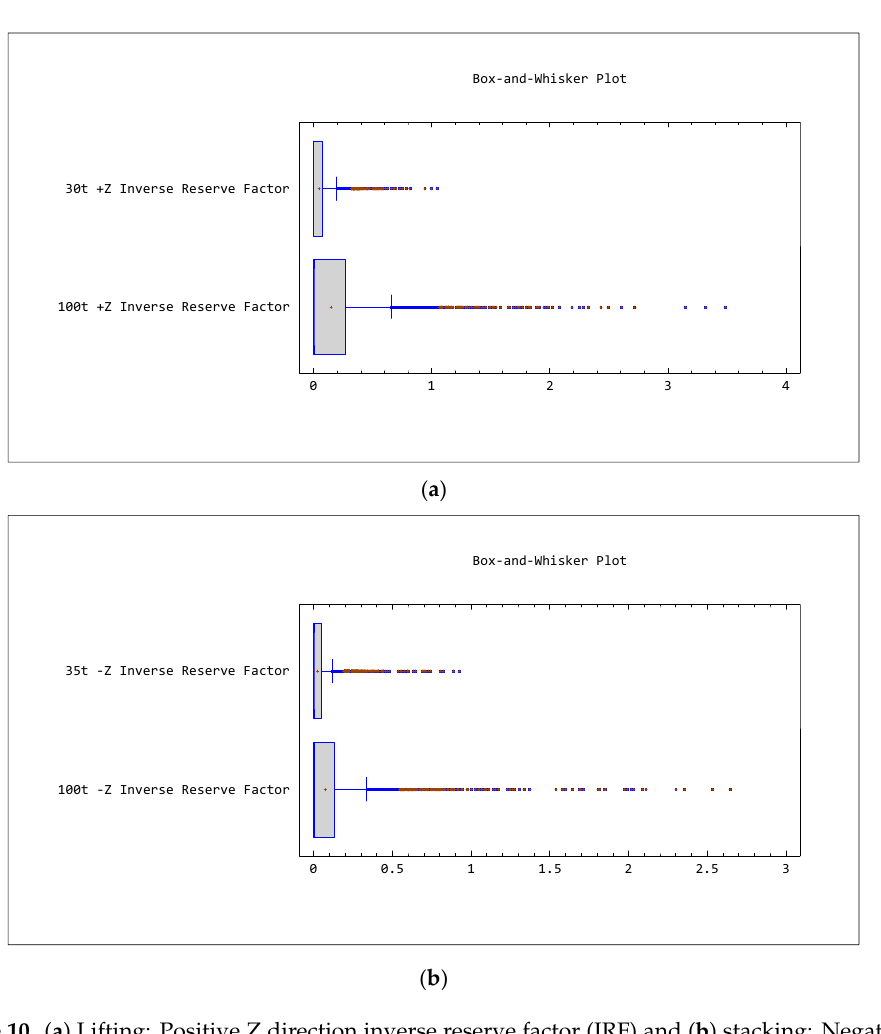
Figure 10. ( a ) Lifting: Positive Z direction inverse reserve factor (IRF) and ( b ) stacking: Negative Z direction IRF.